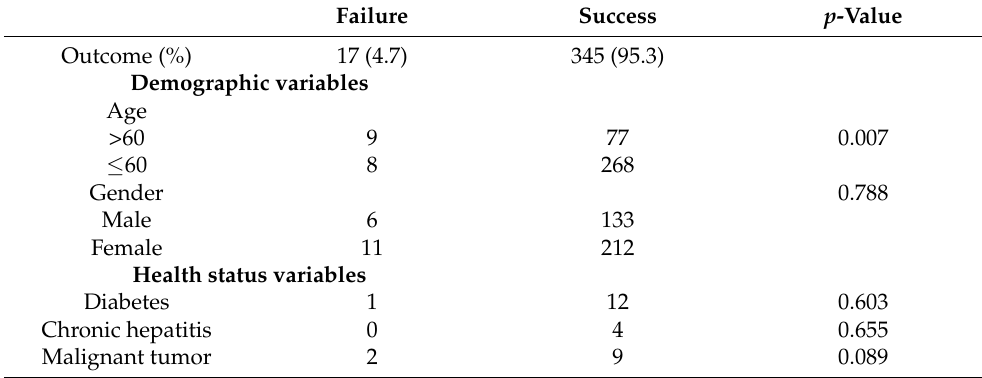
Table 2. Compared distribution of predictive variables based on the results obtained after endodontic